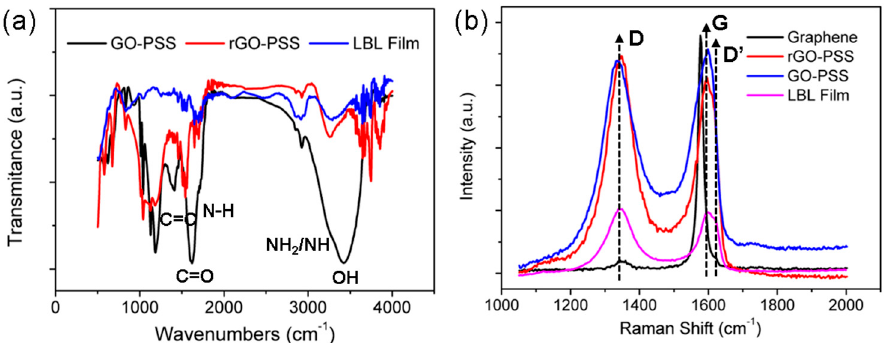
Figure 4. ( a ) FT − IR and ( b ) Raman spectra of GO − PSS, rGO − PSS, and the 100 − bilayer LBL film.